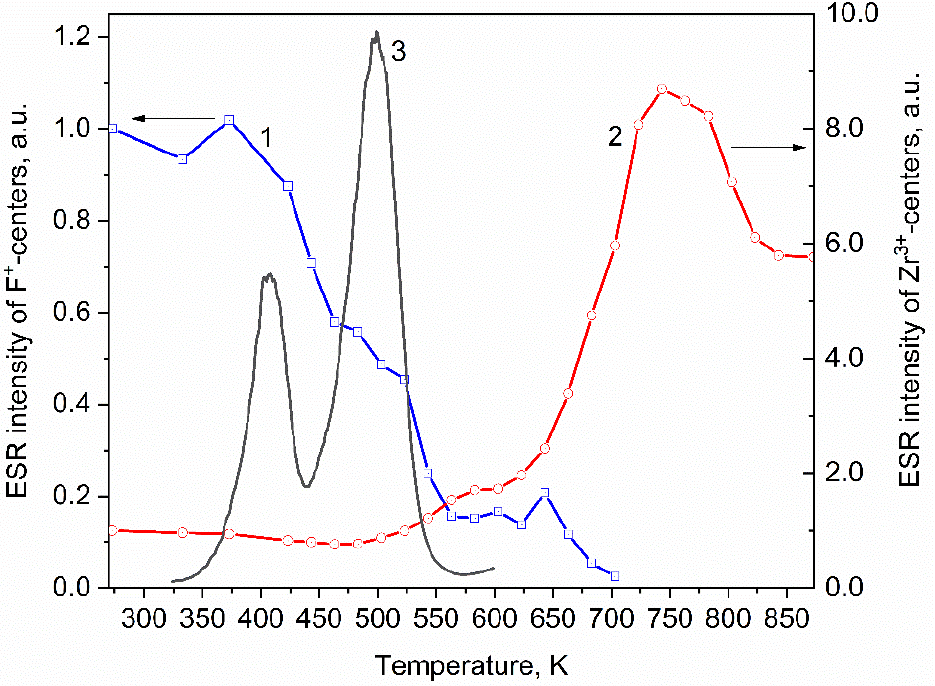
Figure 2. Dependence of the intensity of the ESR signal of F + -centers (1), Zr 3+ ions (2) on the heating temperature and TL (3) of ZrO 2 irradiated with an electron beam with an energy of 10 MeV.